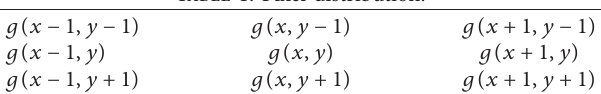
Table 1: Pixel distribution.